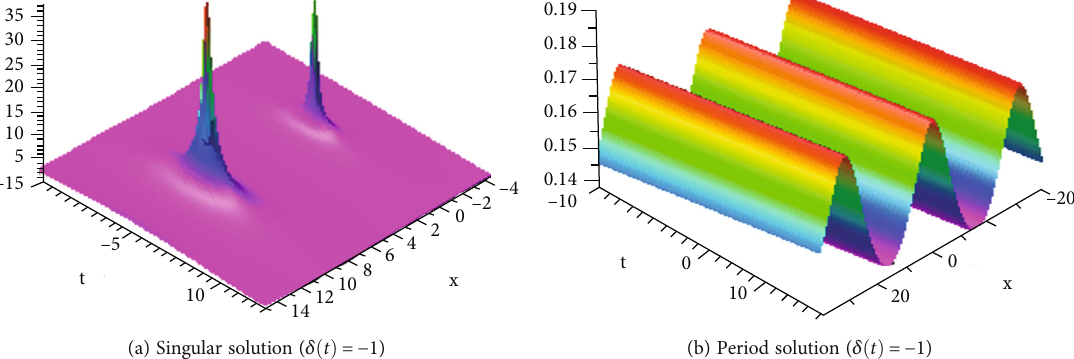
Figure 1: (a) Soliton solution with singularity with parameters a = 0 : 12 and b = − 0 : 35 . (b) Spatial period soliton solution with parameters a = 0 and b = 0 : 2 , period M = 5 π .